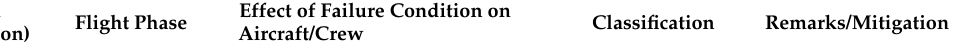
Table A4. ADS FHA for